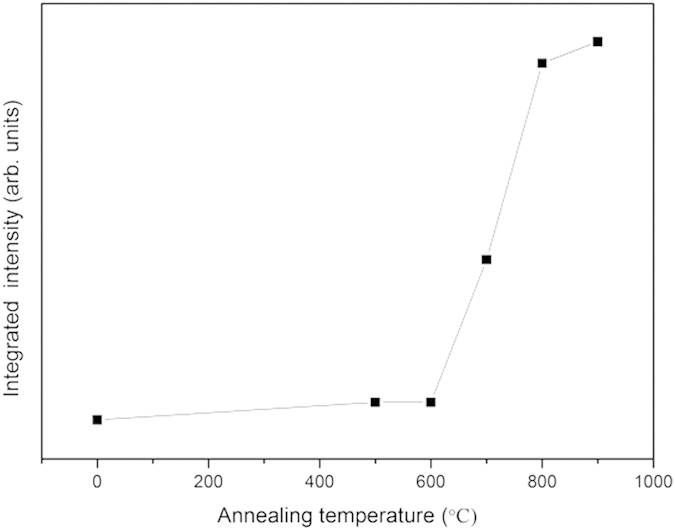
Integrated blue PL intensity as a function of the annealing temperature in vacuum.